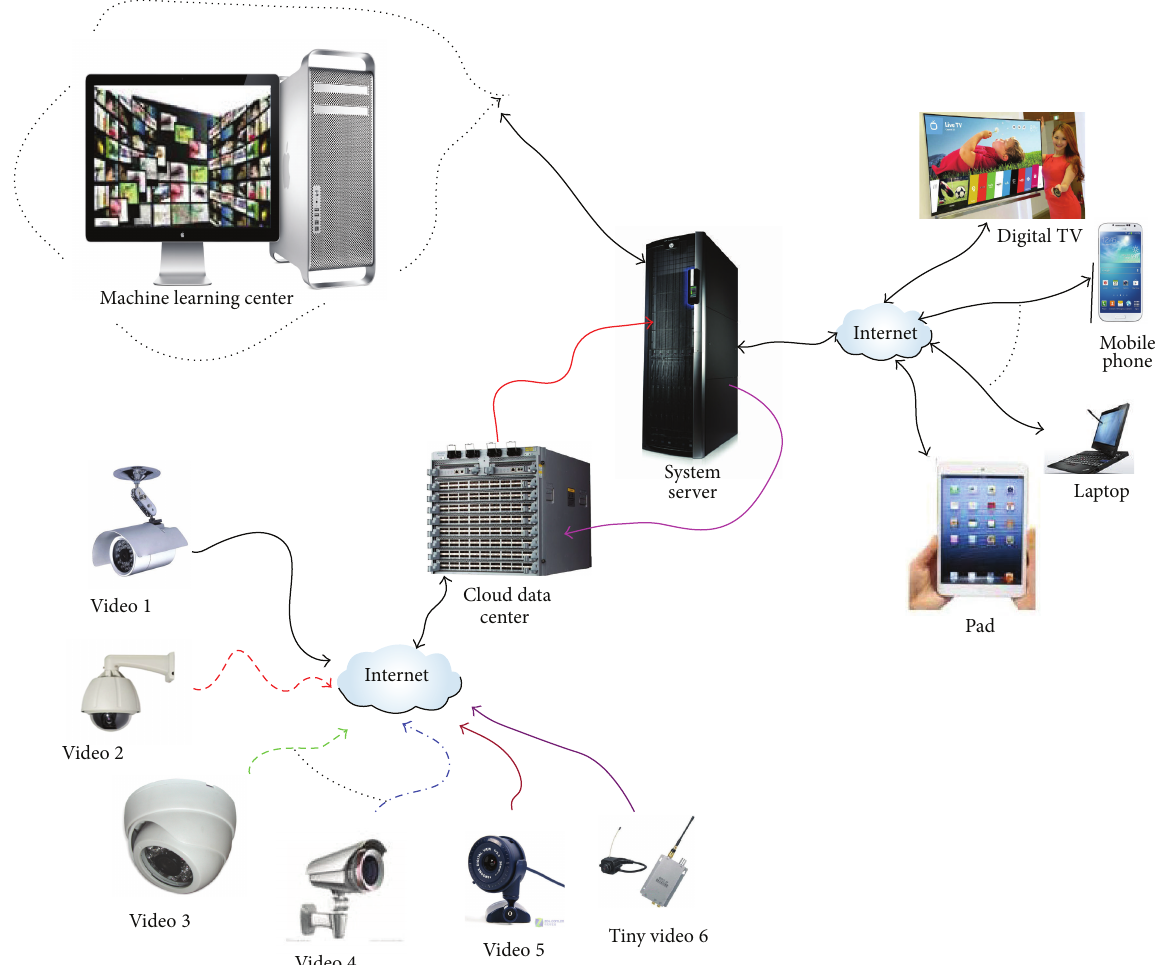
Figure 1: Basic information framework of intelligent video and automated monitoring. More video sources can be collected from video 1 to video 5. In special case, tiny videos are also employed to get video records. The data sets (usually they are big) are submitted to the cloud data center. The services system to handle the videos is the central and important unity. The machine learning system is set up to learn the knowledge or pattern from the special videos according to the users’ needs or conditions. In this system, many popular technologies can be employed, such as data mining, manifold learning, kernel learning, image and video processing, and optimization methods and algorithm. In some cases, the machine learning system can transfer the information to users with emails from internet, short messages by mobile communication system, or other dedicated devices (example digital TV